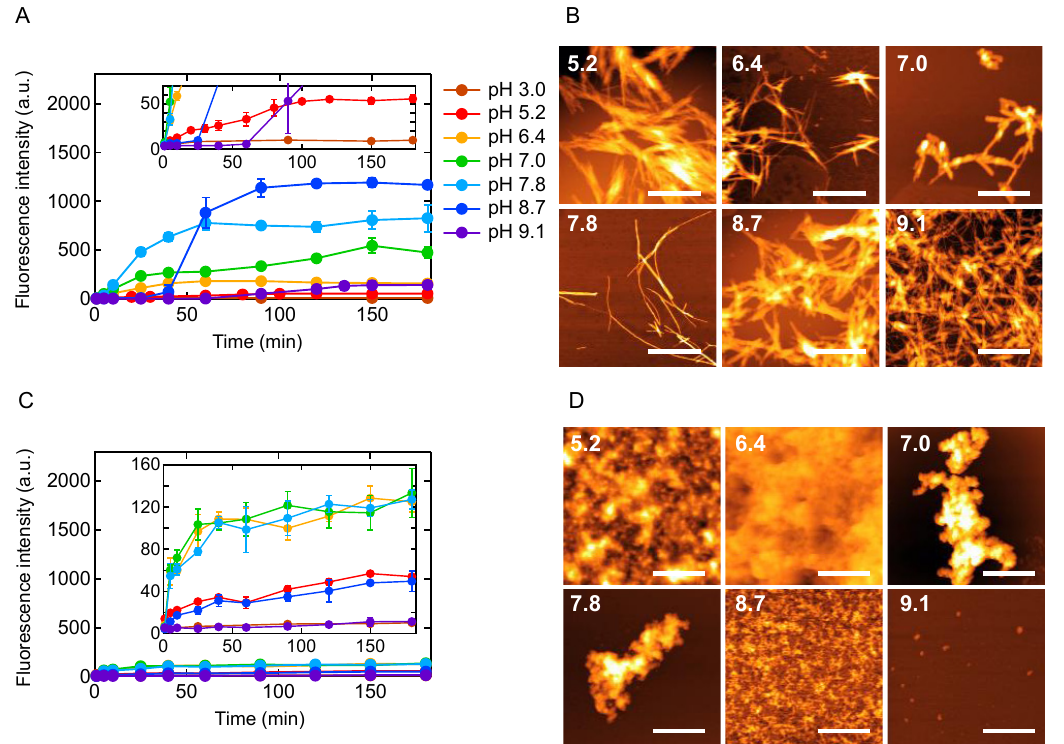
Figure 1. Aggregation reactions of insulin B chain at various pHs under ( A , B ) agitated and ( C , D ) quiescent conditions. The B chain at a concentration of 1.40 mg/mL was incubated at 25 °C, and in agitated conditions, the sample was shaken continuously at 1200 rpm. ( A , C ) Time courses of ThT fluorescence intensity under ( A ) agitated or ( C ) quiescent conditions. The mean values of triple data are plotted with standard deviations as error bars. ( B , D ) AFM images of aggregates after incubation for 2.5 h under ( B ) agitated or ( D ) quiescent conditions. Scale bars represent 1 μ m.